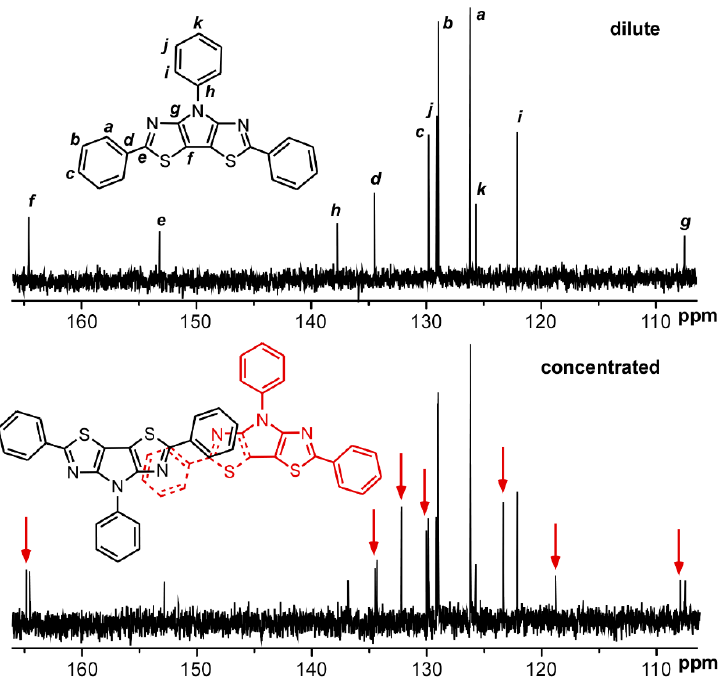
Figure 5. 13 C NMR spectra of oligomer 3b in both dilute and concentrated conditions (new peaks highlighted with red arrows).